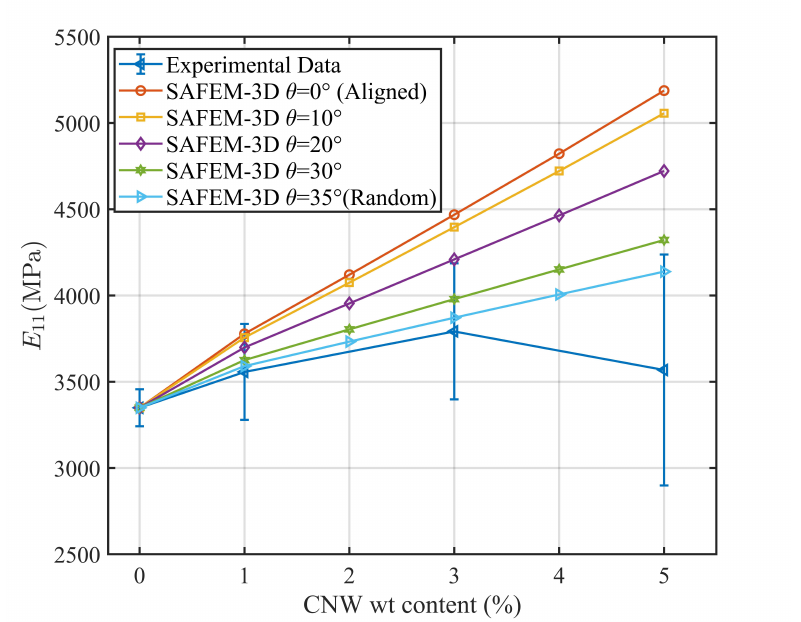
) as a function of the carbon nanowire (CNW) 11